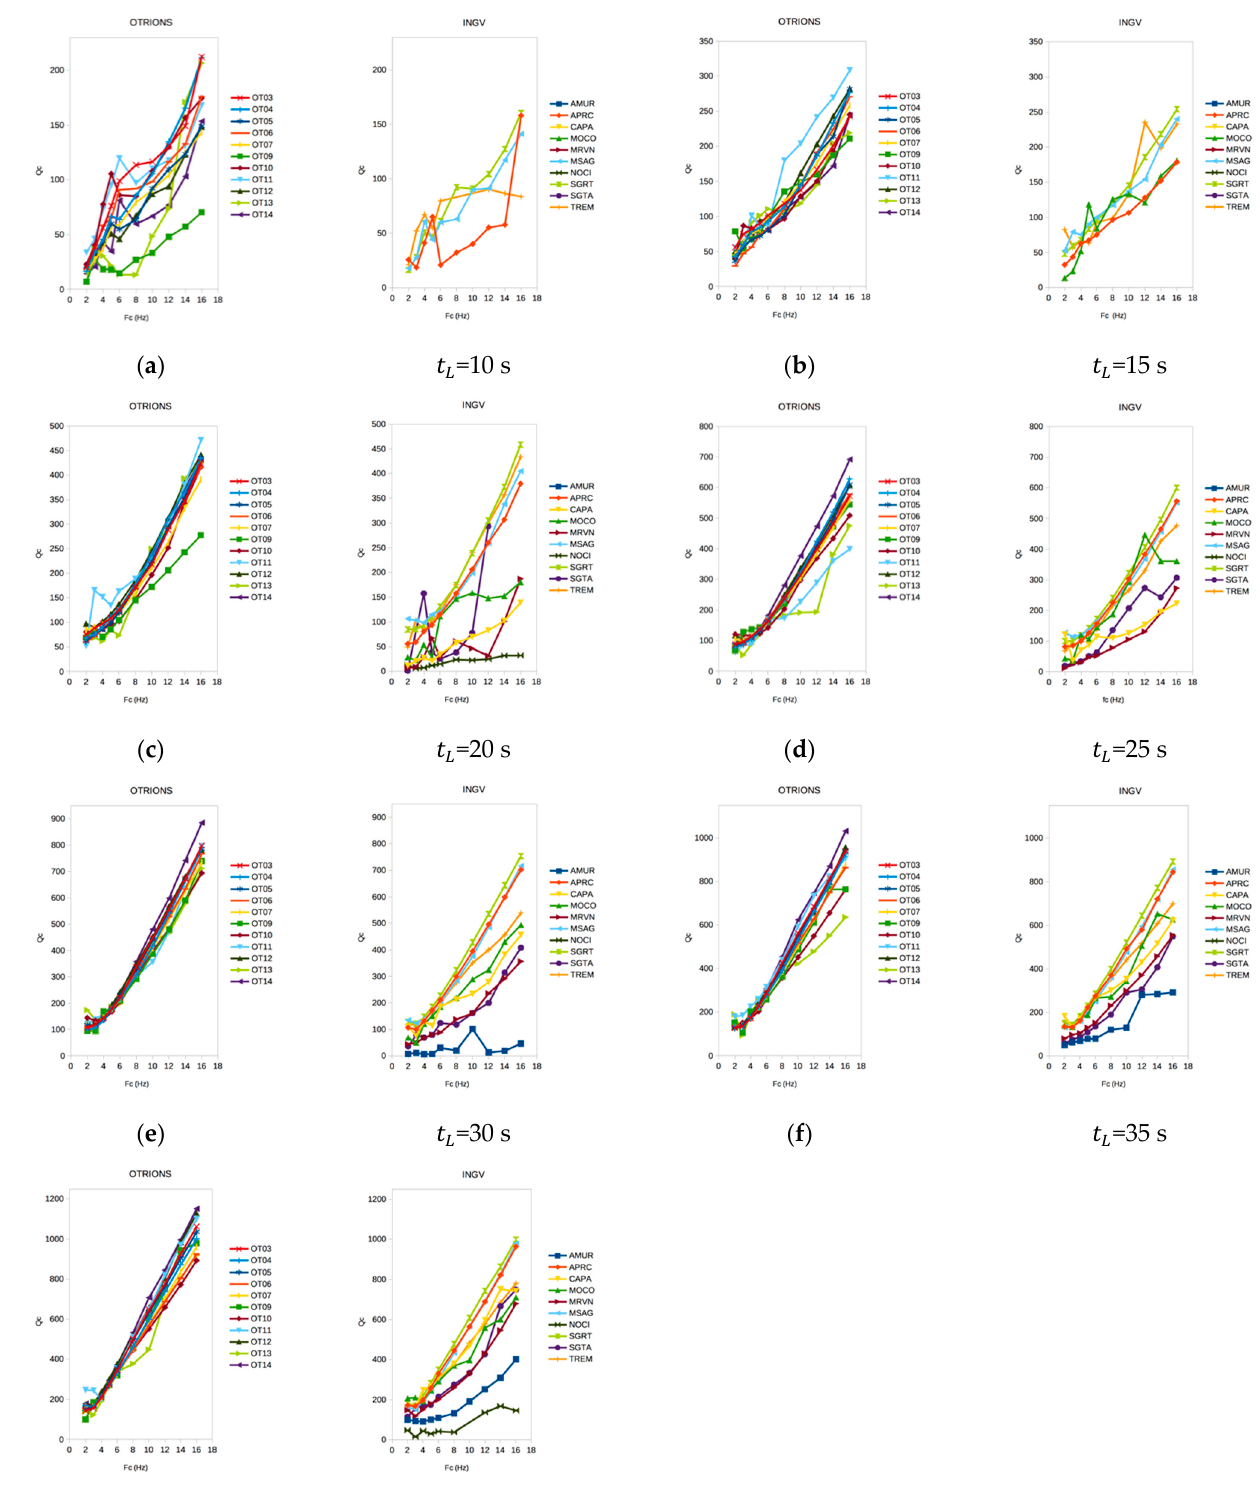
Figure 6. Q st c estimates for each central frequency f c , for all the recording OT and IV stations. The Q c values are distributed Figure 6. 𝑄 (cid:3030)(cid:3046)(cid:3047) estimates for each central frequency 𝑓 (cid:3030) , for all the recording OT and IV stations. The 𝑄 (cid:3030) values are more irregularly for the 10 s lapse time. ( a – g ) show the station Q c vs. f c for increasing lapse distributed more irregularly for the 10 s lapse time. ( a – g ) show the station 𝑄 (cid:3030) vs. 𝑓 (cid:3030) for increasing lapse times.